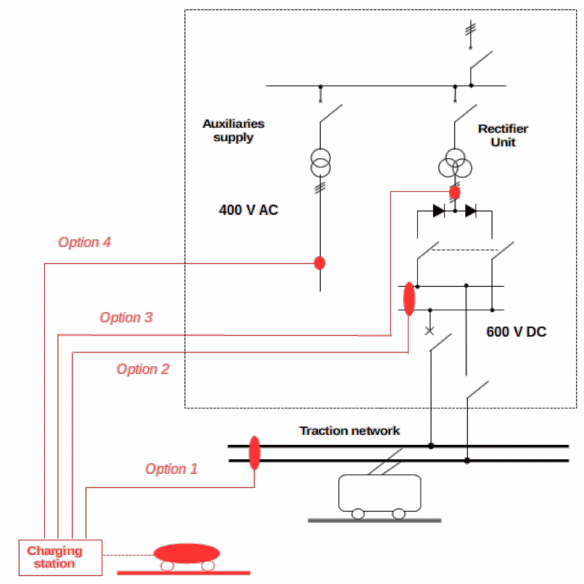
Figure 2. Possibilities of supplying electric vehicle charging stations from a traction power